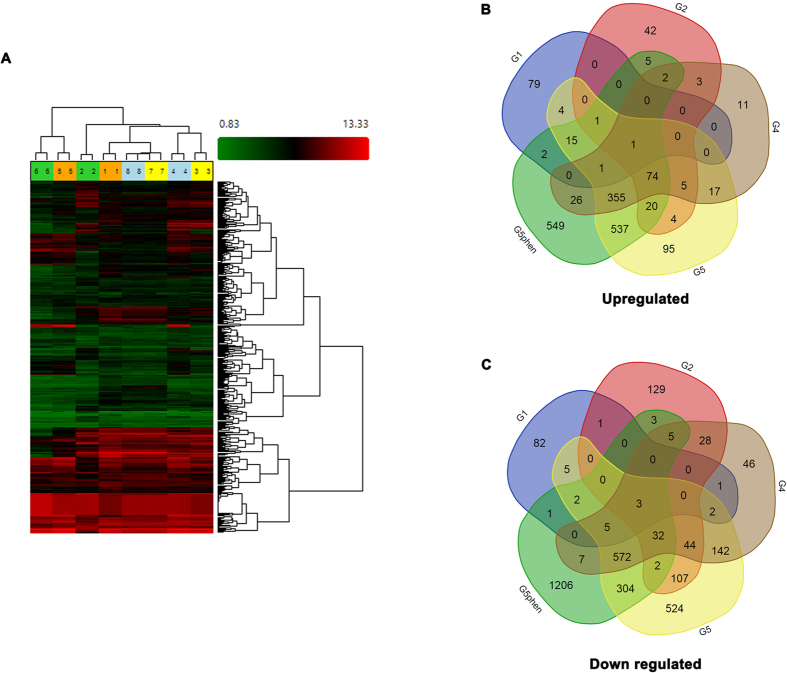
Nuclear reprogramming in DNMT3L expressing Drosophila: Microarray data analysis.(A) Heat map depicting hierarchical clustering of differentially expressed genes in the various samples and examined by microarray analysis. The heat map shows the relative expression levels of each transcript in each samples. Green denotes downregulated, red denotes upregulated and black depicts genes that showed no change with respect to their expression level in control G1 UAS-DNMT3L transgenic larvae. Note the similarity in the heat map profile of the biological replicates for each generation. Sample numbers given above the profile denote: are as follows 1- G1-UAS-3L; 2 to 5 –Tub-3L larvae from generation G1, G2, G4 and G5; 6 – G5-Tub-3L larvae with tumors, 7 – G5-UAS-3L and 8- G20*-UAS-3L* larvae from 20th generation where GAL4 driver was removed. (B,C) Venn diagrams depicting genes upregulated (B) and downregulated (C) in DNMT3L expressing flies across various generations. The number of genes that remain misregulated in successive generations increased progressively (see also Supplementary Table 4). G1 to G5 depict generation number, G5Phen denotes genes misregulated in G5 Tub-3L larvae that had melanotic tumors.